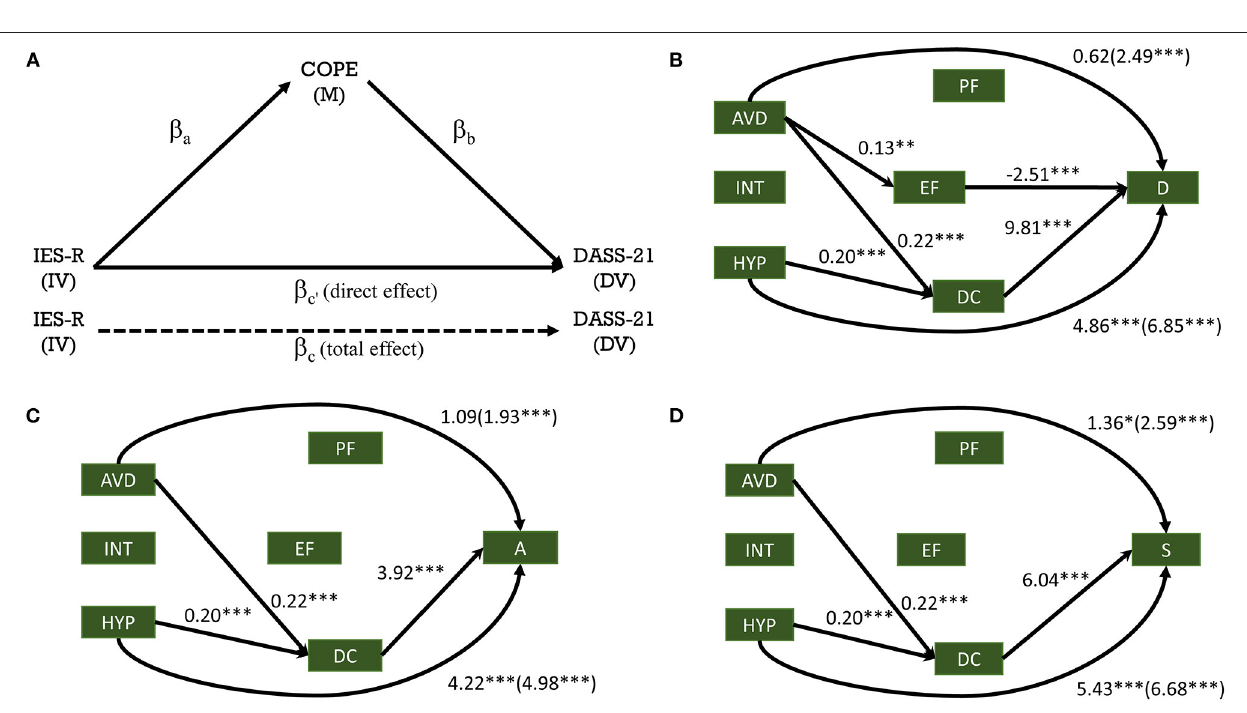
factors/variables that may influence mental health outcomes more potently than the buffering capacity of the coping strategies addressed in this